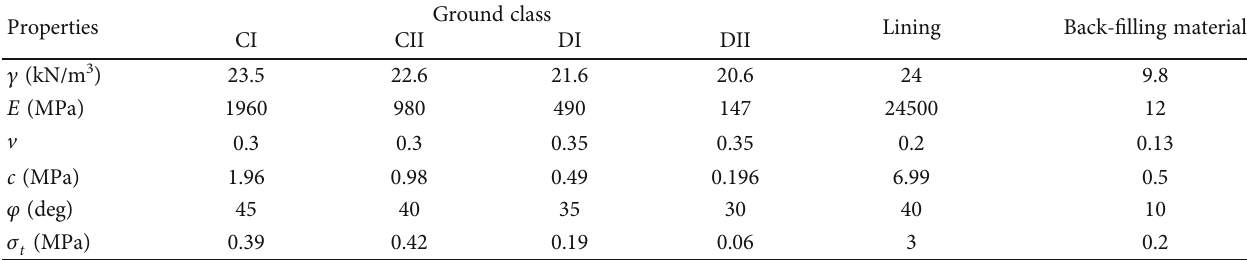
Table 1: Mechanical behaviors of ground, lining, and back- fi lling material.